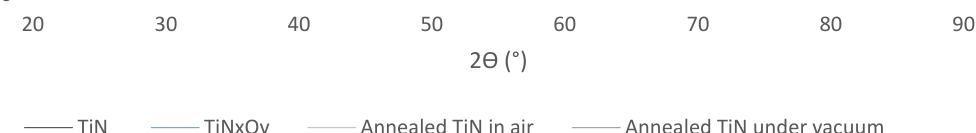
Figure 3. XRD of TiN, TiN x O y , annealed TiN in air, and annealed TiN in vacuum.